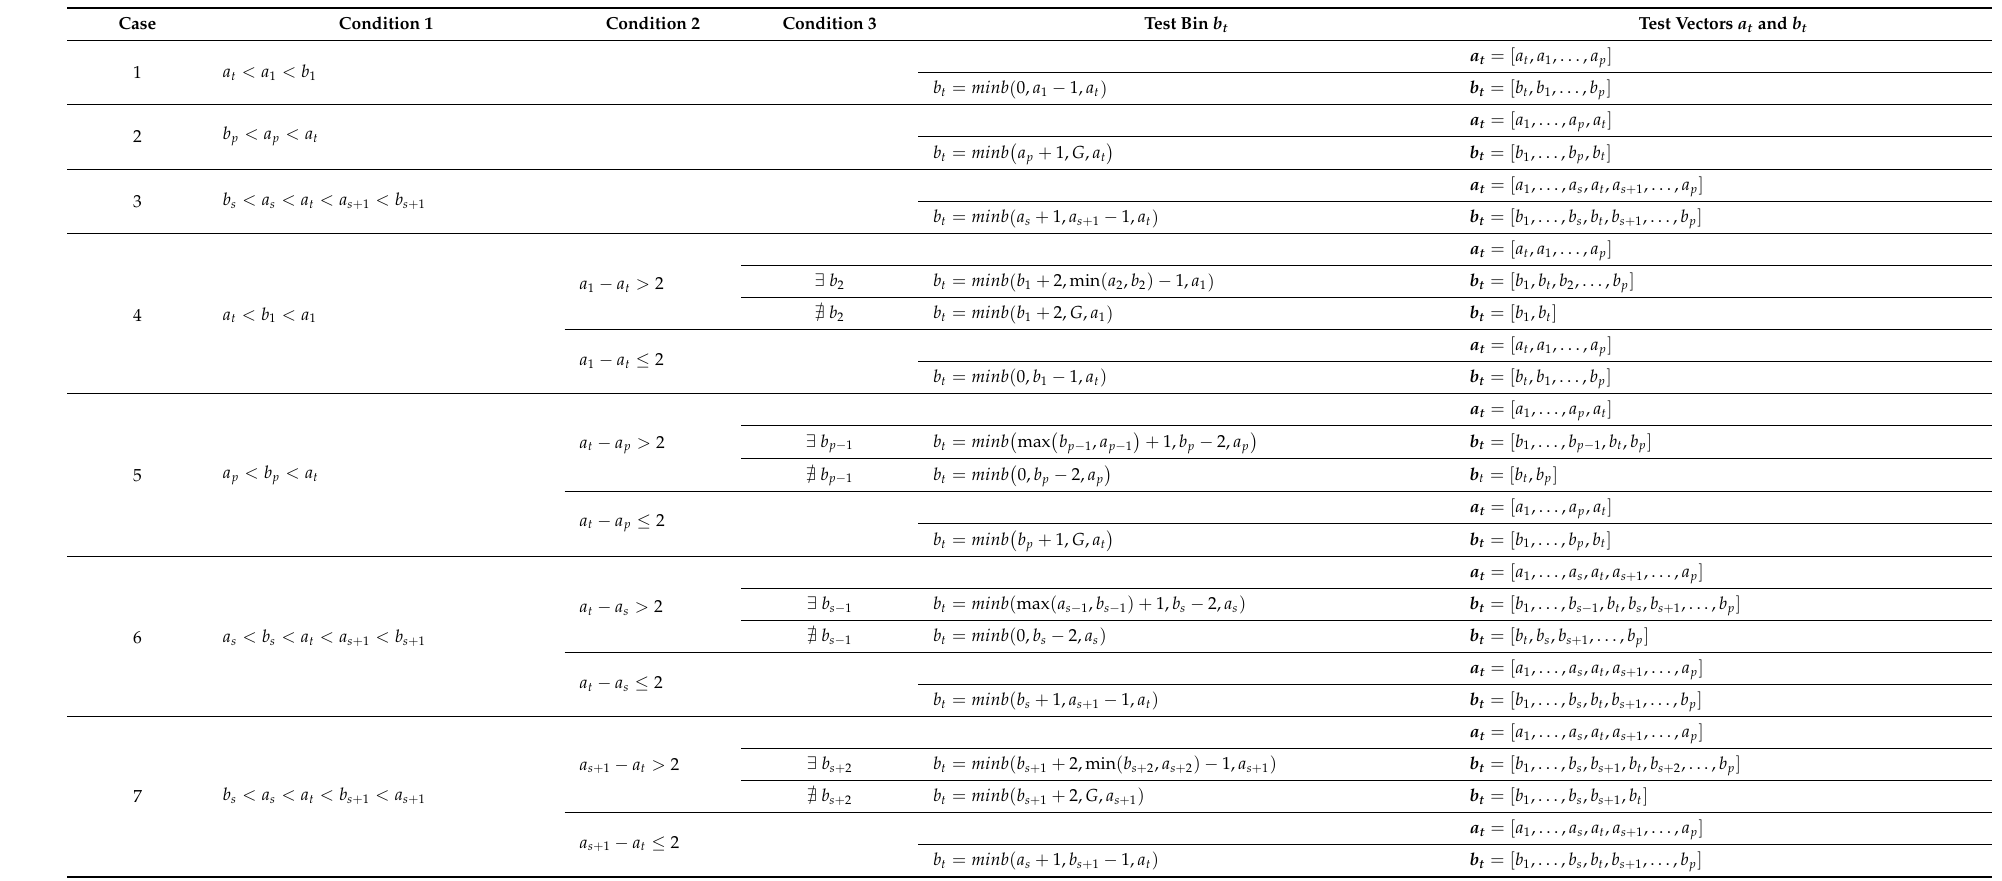
Table 1. Decision table for vector